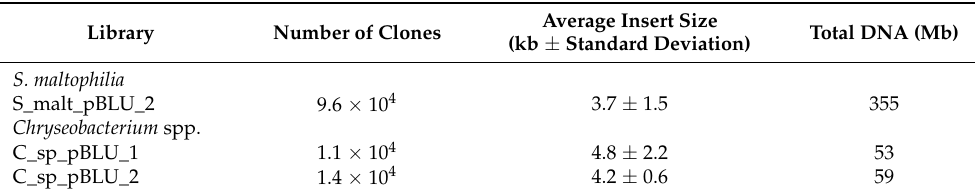
Average Insert Size Total DNA (Mb) (kb ± Standard Deviation)